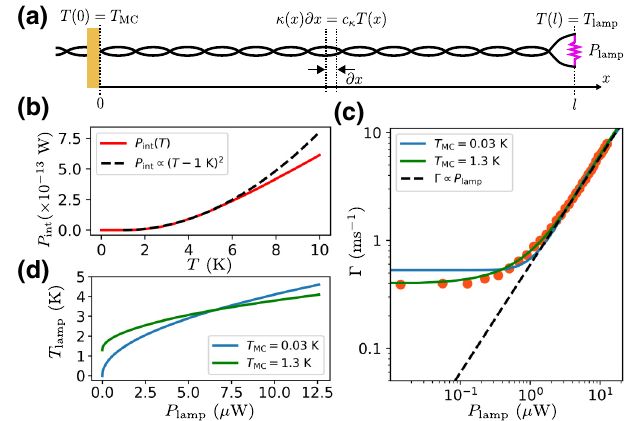
FIG. 12. (a) A diagram of the model for the temperature of the lamp T lamp as a function of the power dissipated by the lamp, P lamp . The thermal conductivity per unit length of the leads is assumed to be linearly proportional to the temperature, which varies as a function of position x along the leads. The temperature at the mixing chamber, T ( 0 ) = T MC , is approximately 30 mK. (b) The power radiated by a 3D black body at temperature T inte- grated from 100 to 300 GHz. We observe that from 1 K to 5 K, the dependence is approximately quadratic in temperature with an offset of 1 K. At higher temperatures, P int ∝ T . (c) The measured (cid:4) as a function of the power dissipated by the lamp (orange). The data are the same as in Fig. 4(b) but here shown in log- log scale. We fit them with the model in which (cid:4) ∝ P int ( T lamp ) , where T lamp depends on P lamp according to Eq. (F2). In blue, we fit assuming that the lamp is at the mixing-chamber temperature when no power is dissipated ( T MC = 0.03 K). The model cap- tures the linear behavior between approximately 1 and 10 μ W but not the low-power dependence of (cid:4) . In green, in an attempt to fit (cid:4)( P lamp < 1 μ W ) , we allow T lamp at P lamp = 0 μ W to vary as a fitting parameter, which yields T MC = 1.3 K. This is an unreasonably high temperature, indicating that this model does not accurately capture the low-power behavior. (d) The tempera- ture of the lamp T lamp as a function of P lamp , calculated using the fitting parameters of (b). In blue, T lamp ( 0 ) is assumed to be the mixing-chamber temperature, while in green, T lamp ( 0 ) = 1.3 K. In both cases, T lamp ∝ P lamp1 / 2